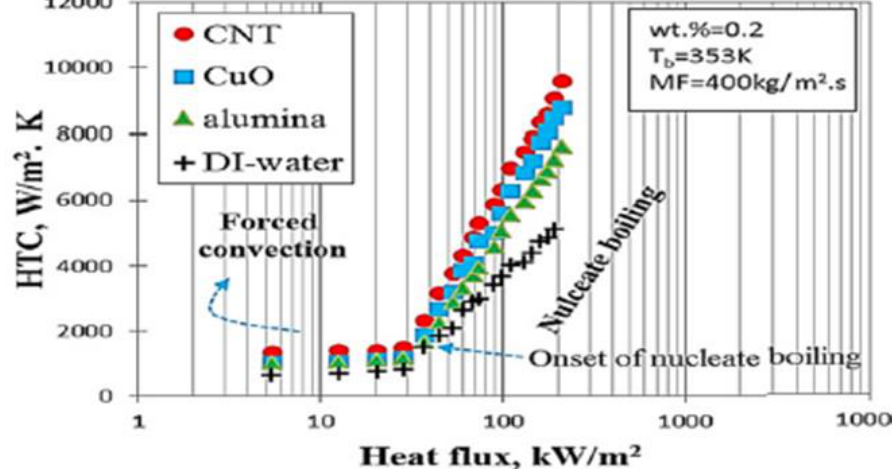
Figure 5. Influence of heat flux on HTC of different nanofluids in forced convection and nucleate boiling regions [71].